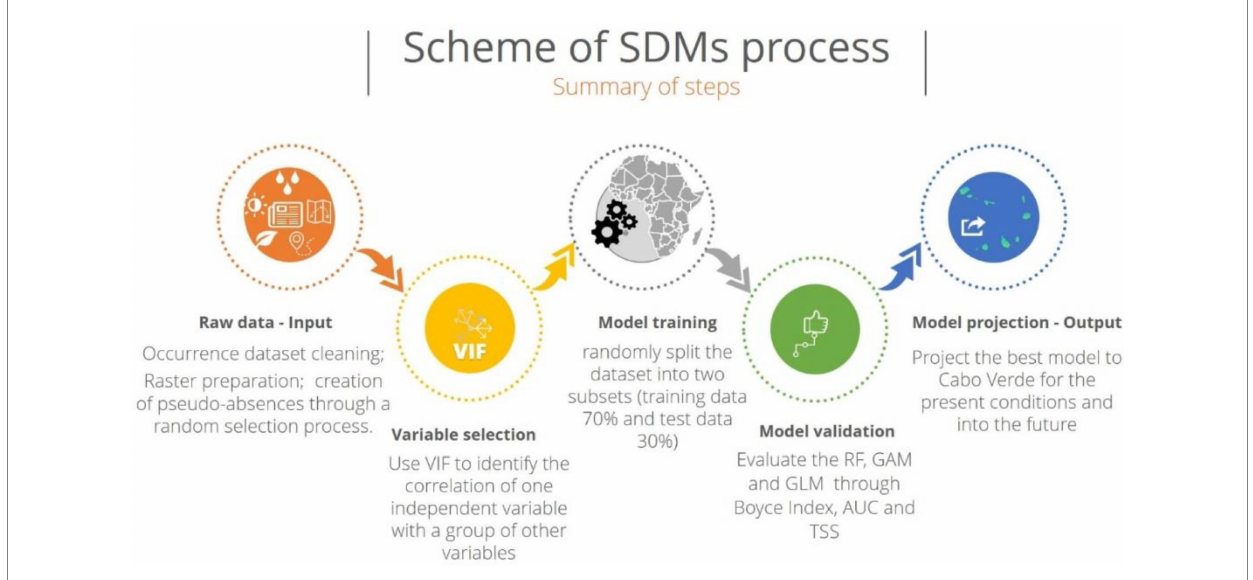
FIGURE 2 General scheme of the modelling framework, based on Silva et al. (2019, 2021) and on Varela et al.